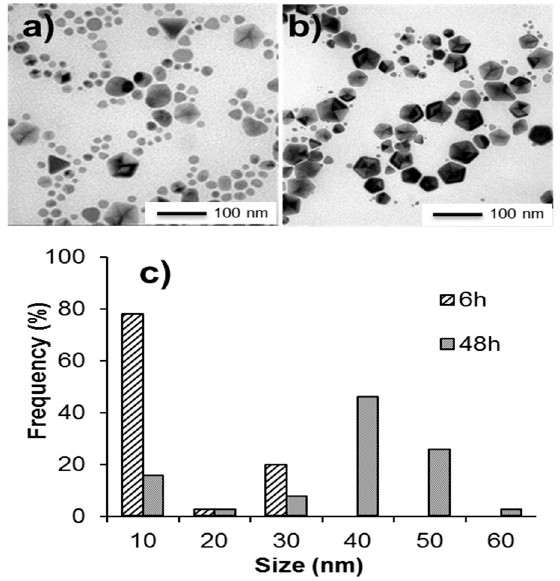
Figure 3. ( a , b ) TEM images and ( c ) particle size distribution of silver nanoparticles after 6 h and 48 h of irradiation.